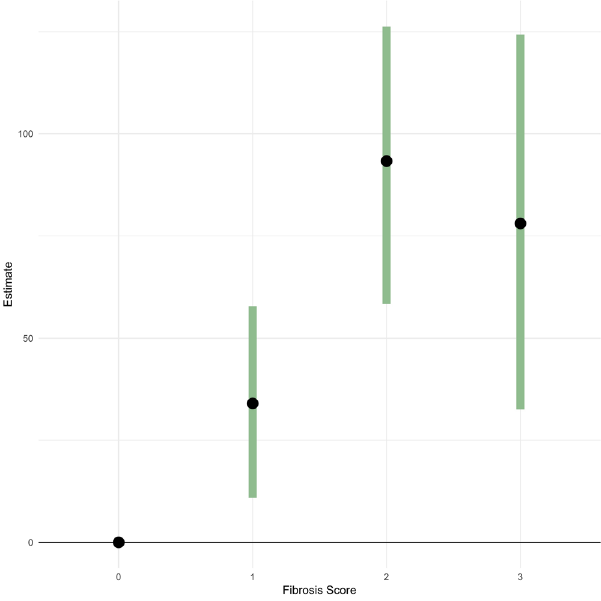
Figure 6. Point estimates and 95% Confidence Intervals for different fibrosis scores. Figure shows the estimated increase in slaughter age in days for an animal with 345 kg carcass weight for fibrosis scores 1–3 compared to a fibrosis score of 0, as estimated by the fibrosis model.